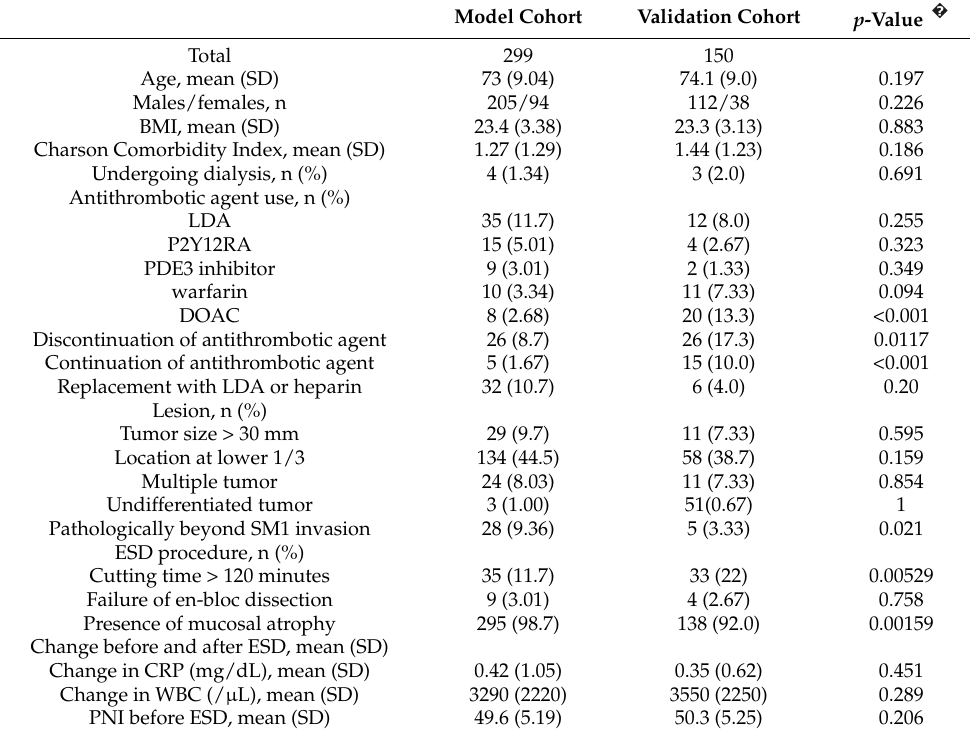
Table 1. Clinical features and characteristics in model cohort and validation